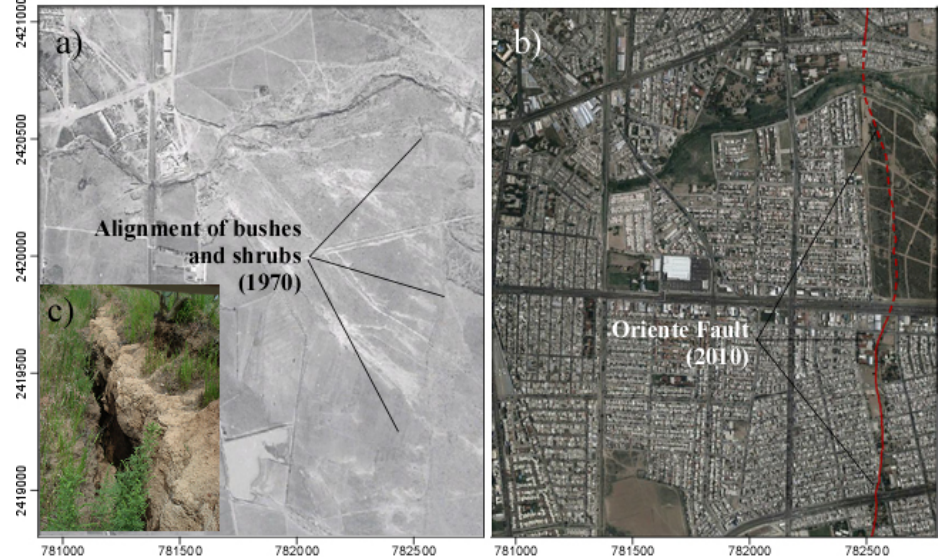
Figure 3. Comparison of two zones before and after intensive pumping (modified from Pacheco-Martínez et al., 2013). The particular location of this area is indicated in Fig. 1 with number 4.